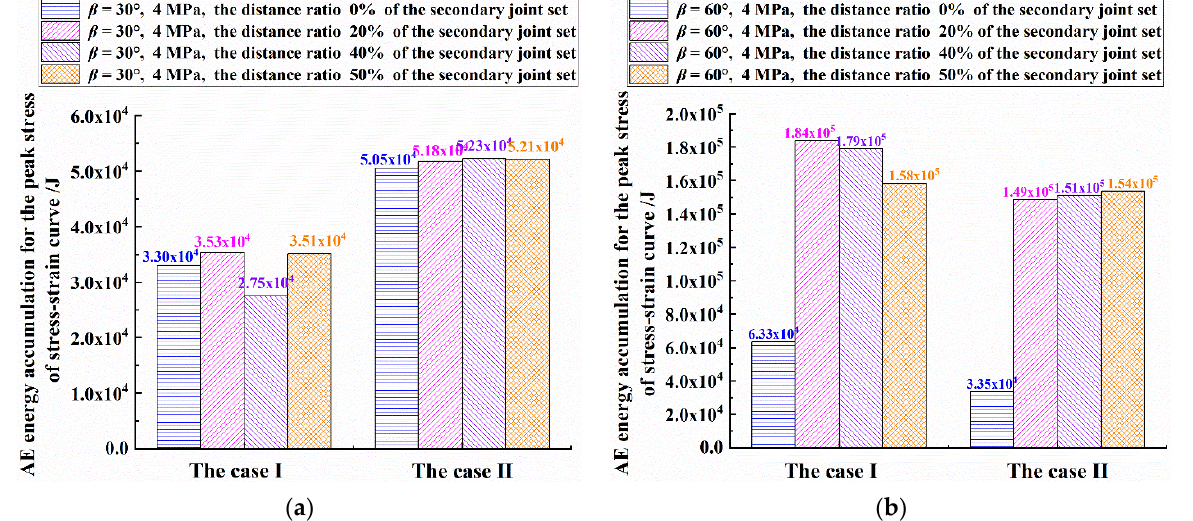
Figure 19. For the case of two kinds of model boundaries, for the CJBs with different joint distance ratios: ( a ) the accumulated AE energy corresponding to the stress peaks, for β = 30°; ( b ) the AE energy accumulations corresponding to the peak stresses, for β = 60°.